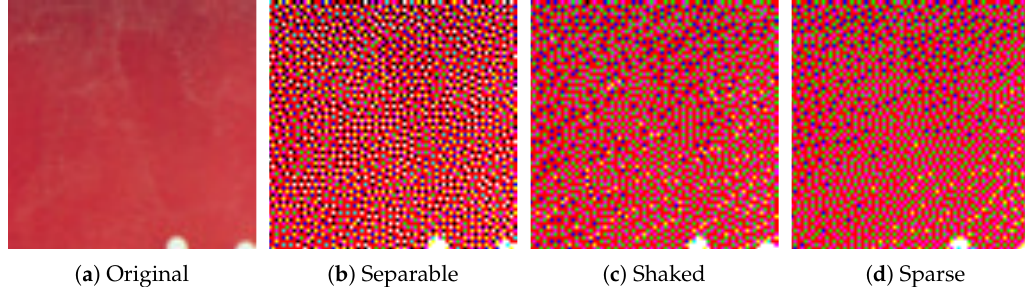
Figure 16. Zoomed parts of Milkdrop images.